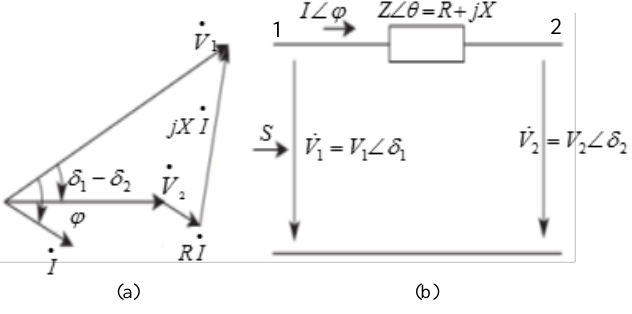
Figure 2. Power flow in MGs. ( a ) voltage vector and ( b ) power flow